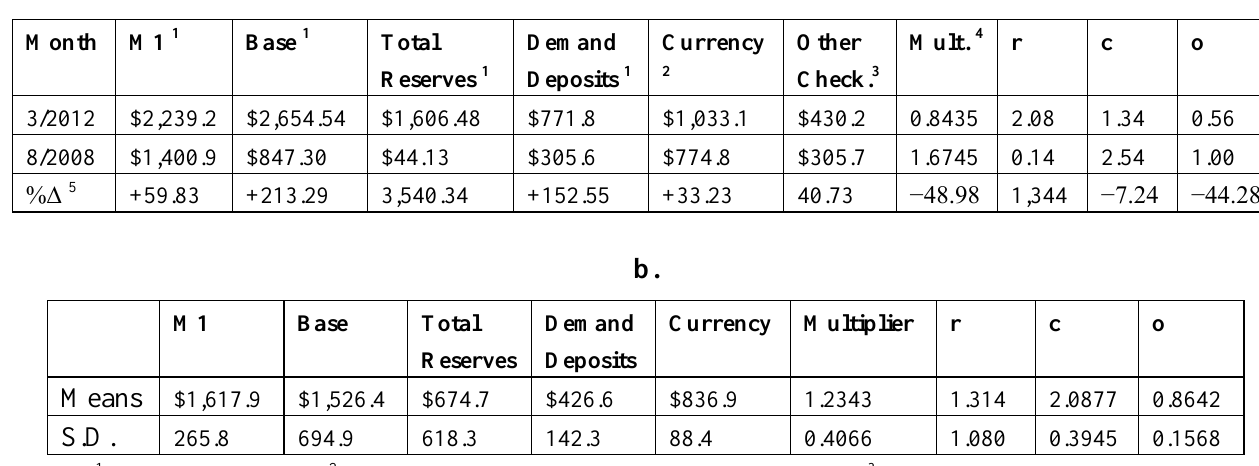
Table 2. a. Basic Statistics for M1 and Its Multiplier. b. Mean Averages and Standard Deviations Over Period 8/2008 to